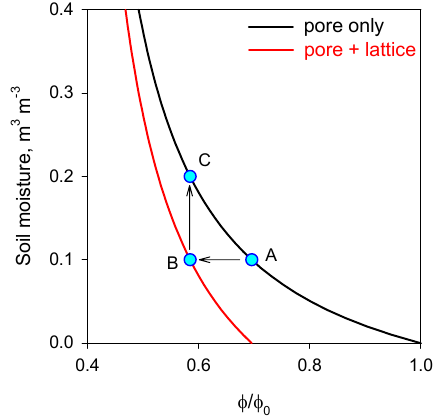
Fig. 6. Calibration function derived from MCNPX modeling for soil with no lattice water (black) and with the equivalent of 0.1m 3 m − 3 lattice water (red). A, B and C are hypothetical calibration points when lattice water is neglected (A), when it is included (B) and when it is included and plotted on the original calibration line